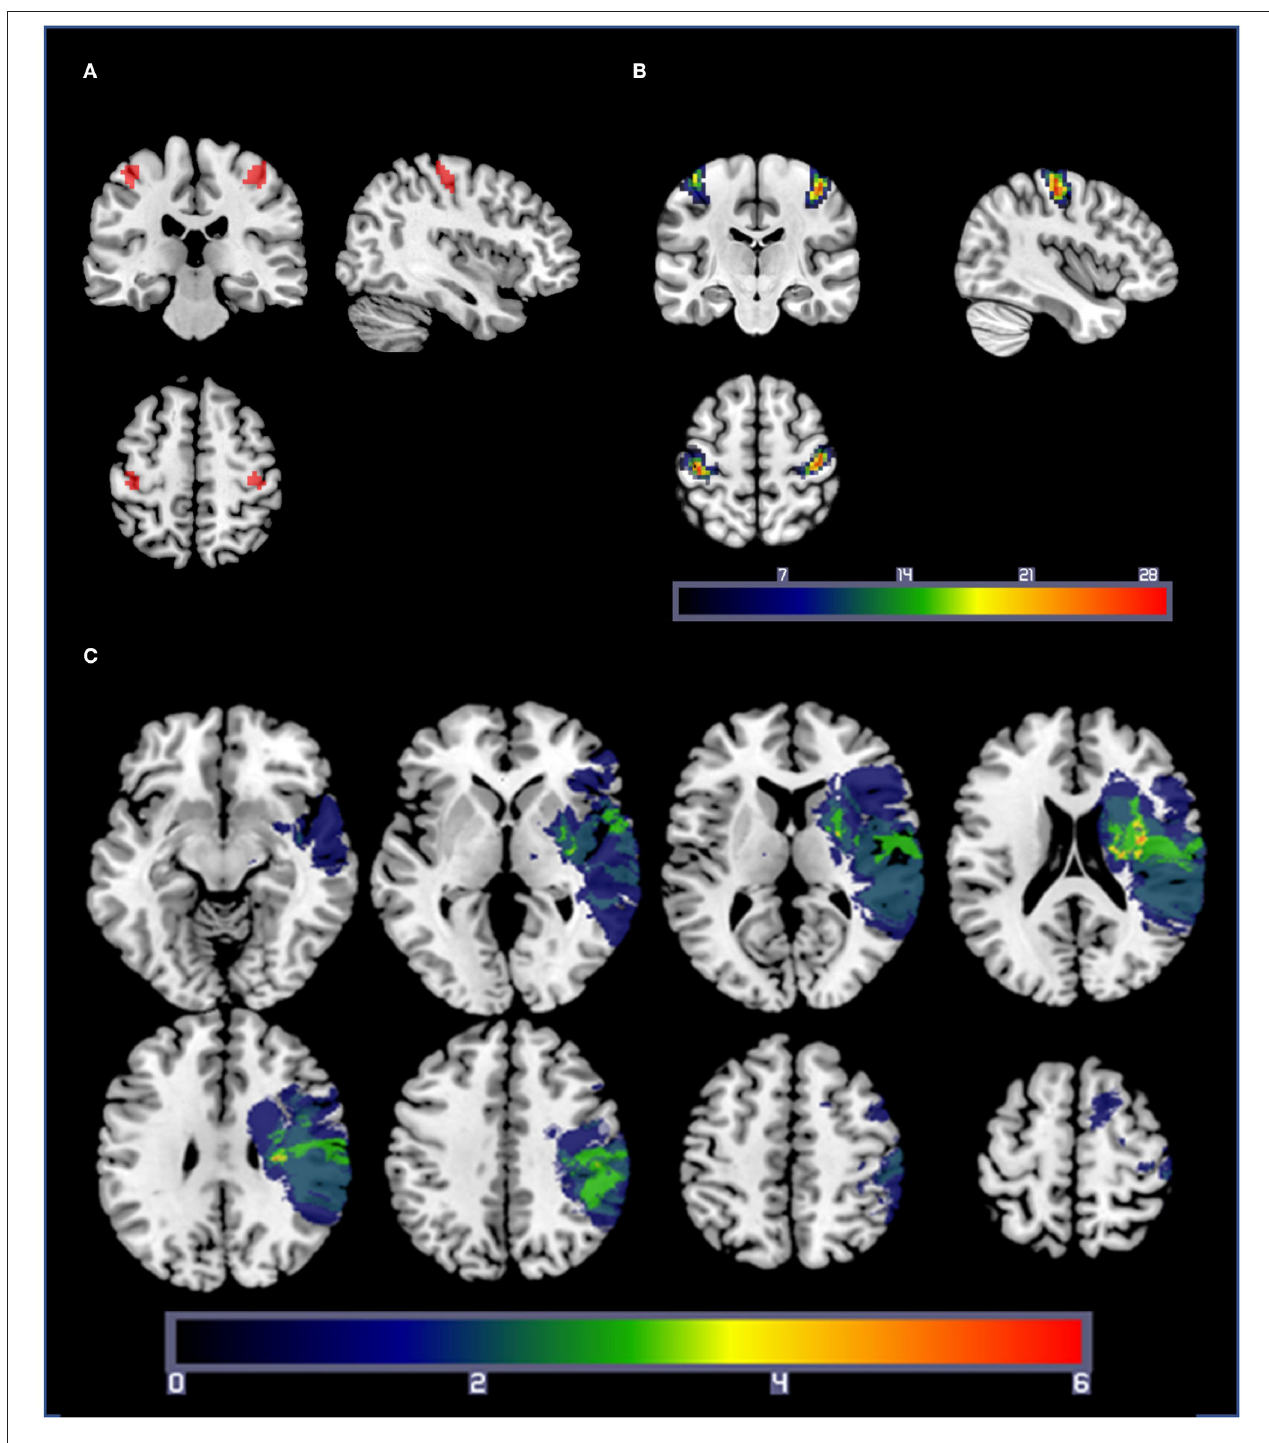
FIGURE 2 | (A) A representative set of M1 ROIs from a healthy control participant, based on the comparisons of right-hand movement > rest and left-hand movement > rest from the hand localizer scan. Statistical thresholds were set on an individual basis to identify a cluster of 50 contiguous voxels centered in M1 for each participant. (B) ROI overlap map: Summation of M1 ROIs for each participant (healthy controls and patients with stroke). Warmer colors indicate a voxel is included in more ROIs. ROIs were densely clustered over the posterior aspect of the precentral gyrus including the hand knob and the central sulcus. (C) Lesion overlap map: lesion masks from the 19 patients with stroke projected into standard space. Lesions from the right hemisphere were flipped across the sagittal axis for illustration purposes only. Warmer colors indicate a voxel is present in more participants’ lesion masks.